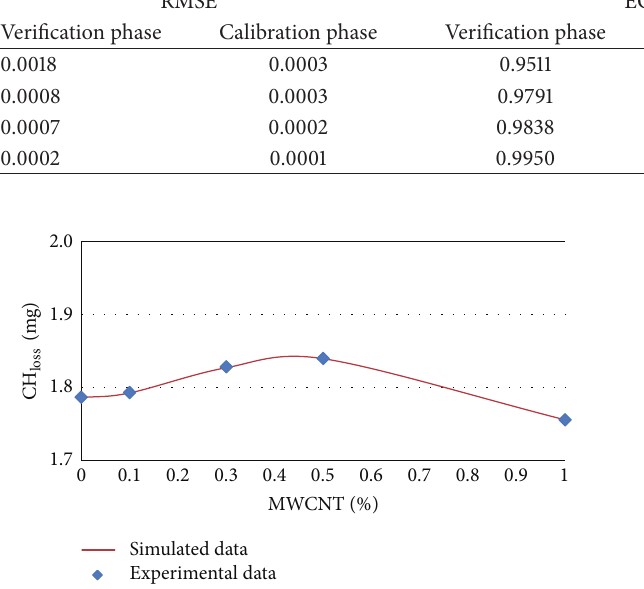
Figure 11: Experimental and simulated values of CH loss for 28 days by artificial neural networks.